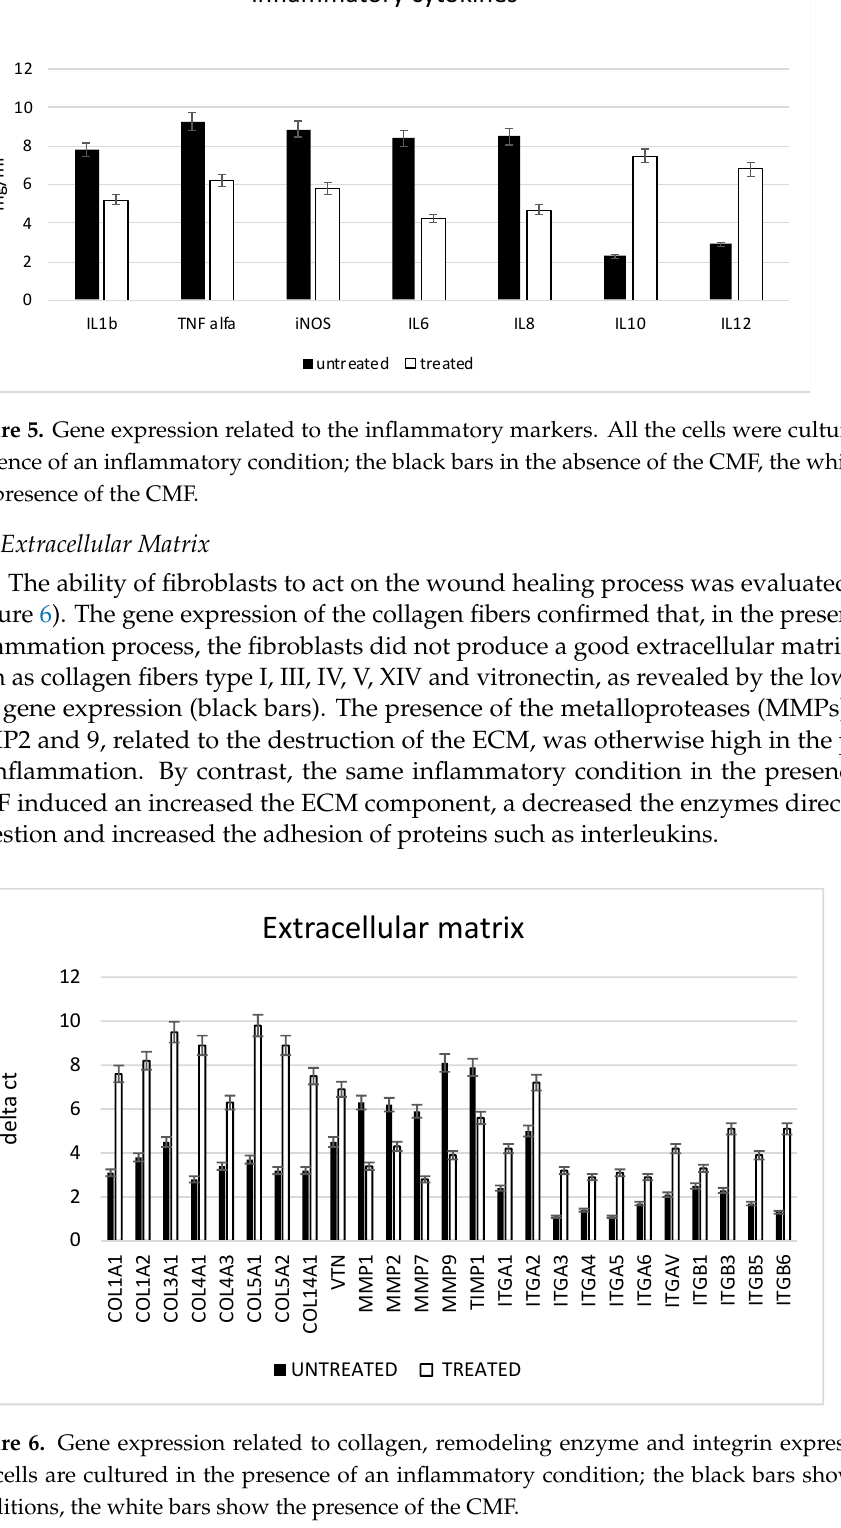
Figure 4. SEM analyses of the macrophages without the CMF treatment ( A ) acquires a M1 inflam- matory rounded shape phenotype (red circles). Treatment with the CMF ( B ) induced the M2 anti- inflammatory phenotype characterized by a long fusiform shape (yellow circles).